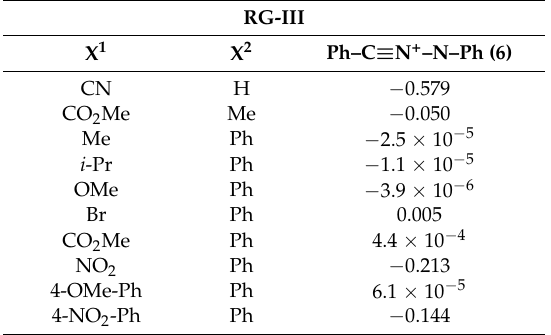
Table 12. Grand potential stabilization difference δ ∆Ω = ∆Ω (5-X 1 ) − ∆Ω (4-X 1 ) (meV) for 1,3-DC of diphenylnitrilimine 6 to alkenes. Negative values indicate that the 5-X-pyrazoline regioisomer is favored. RG-III X